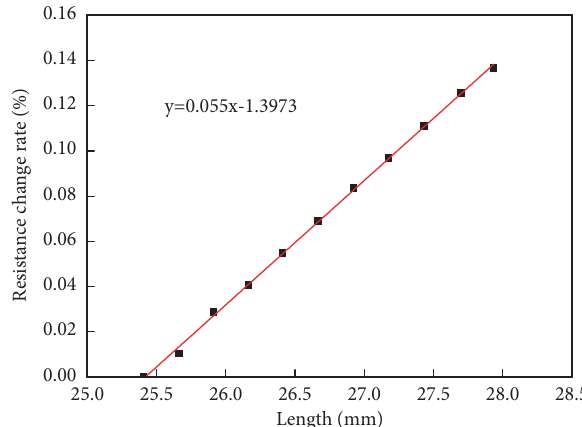
Figure 11: Curve of length and resistance change rate of the carbon nanotube